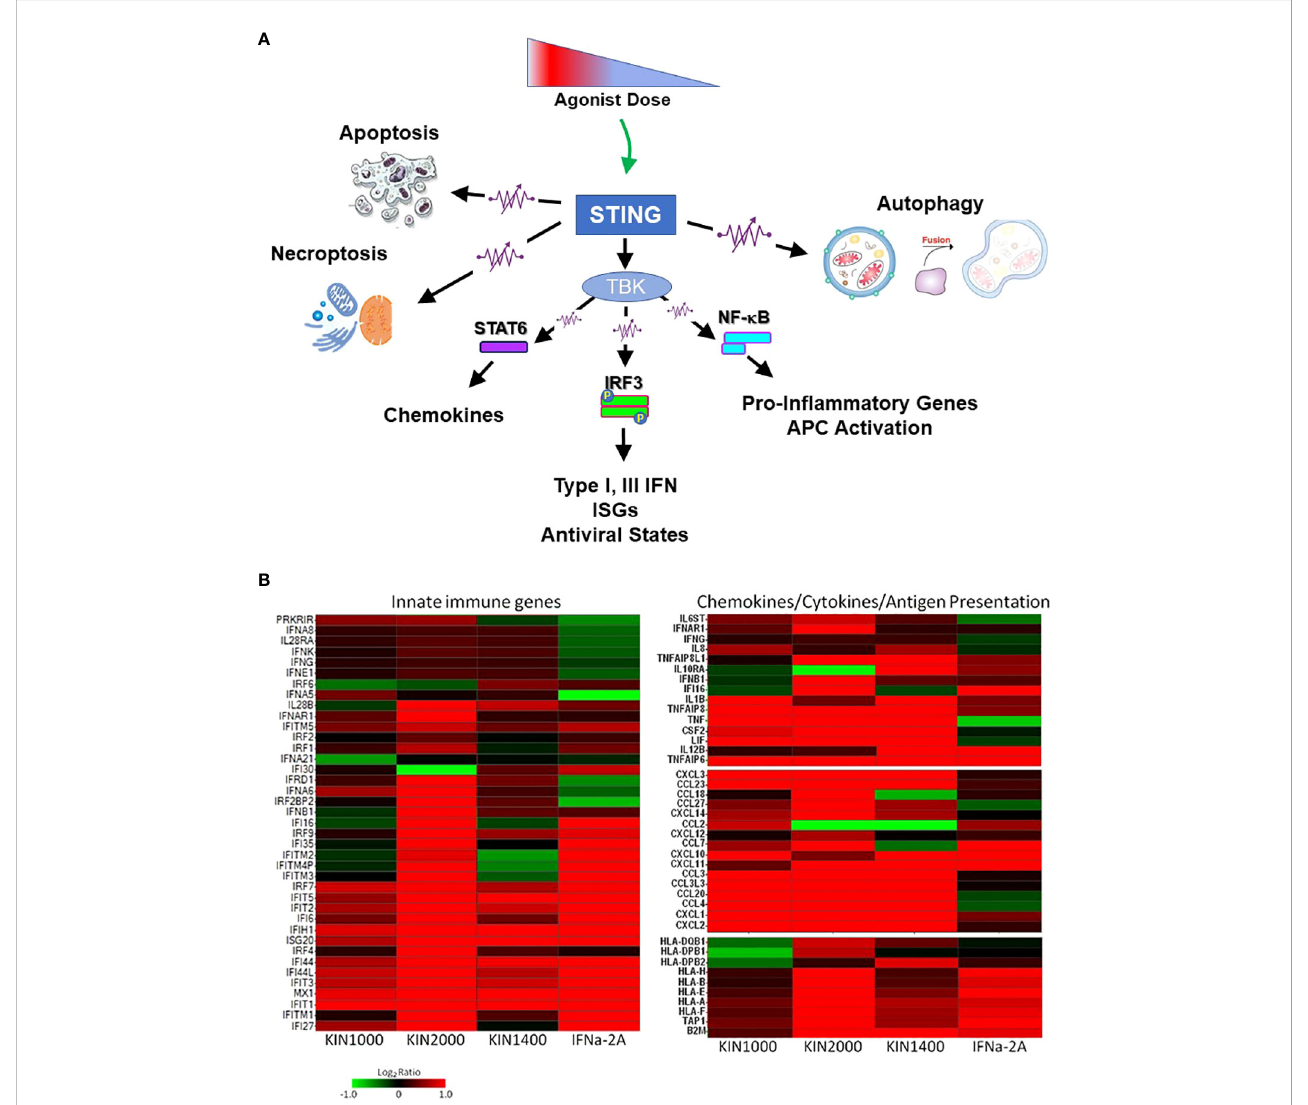
FIGURE 1 Innate immune receptors as tunable, not binary switches . (A) Engaging innate immune receptors such as the intracellular STING (Stimulator of Interferon Genes), a sensor of cytosolic pathogen derived or self-DNA, triggers a spectrum of downstream responses that quantitatively change depending on the dose of the receptor agonist. This supports the concept of innate immune receptors functioning like rheostats (or “ dimmers ” ) rather than switches. (B) In addition to quantitative changes in the response pattern, different agonists (including small changes in the chemical structure of an agonist) can alter the receptor ’ s response pattern qualitatively as shown here for three small-molecule RIG-I agonists ( fi rst described in (7)). The gene expression-pro fi le induced by IFN a -2A is included as a reference. RIG-I (Retinoic acid-inducible Gene-I, RLR-1) is a cytosolic receptor for speci fi c motifs associated with viral RNA and used here as an example for how different synthetic agonists uniquely affect the downstream expression pattern of innate immune, chemokine, and cytokine genes or genes associated with antigen expression. This phenomenon had fi rst been described for TLR4 that signals through two distinct signaling pathways (MyD88-dependent, and MyD88-independent/TRIF-dependent) that could be triggered differentially. However, it also applies to receptors that only utilize one signaling pathway (such as RIG-I, STING, or all other TLRs). The observation suggests that even the rheostat- model of innate immune receptors may be overly simplistic, and a more accurate electronic comparator might be multi-color LED dimmer switches that not only change the intensity of the signal (LED brightness/level of gene expression), but also the quality of the signal (LED color/gene expression pattern). Data provided by M.Gale and RC Ireton, University of Washington, Seattle